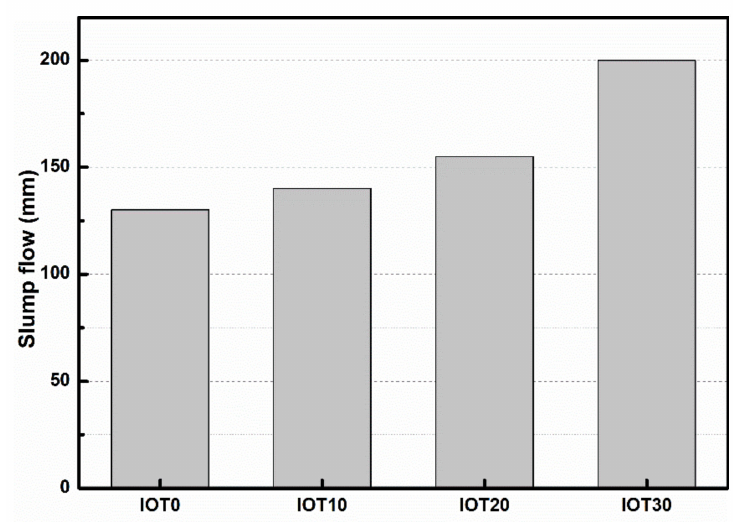
Figure 5. Effect of iron ore tailing on the slump flow of designed